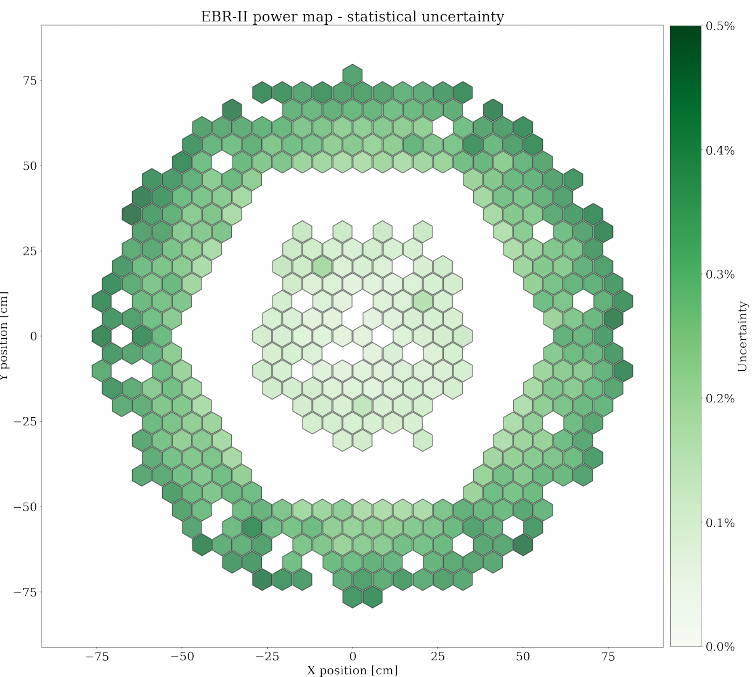
Figure 9. KENO-MG statistical uncertainty of the axially integrated assembly powers using ENDF/B-VII.1 data.